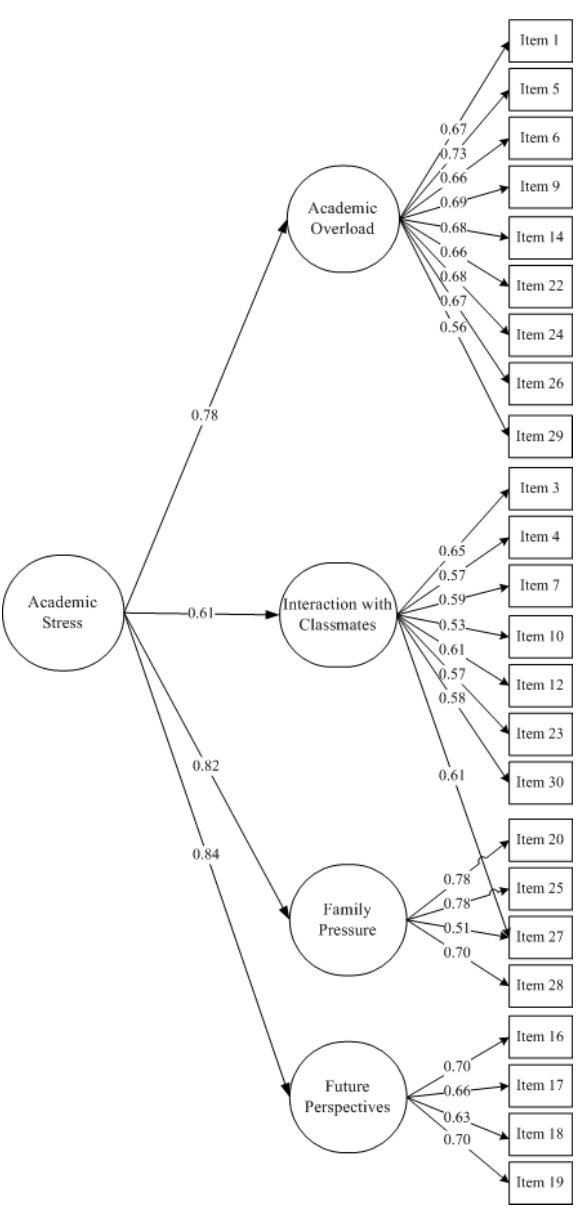
Figure 1. Standardized factor loadings for the M3r# model.